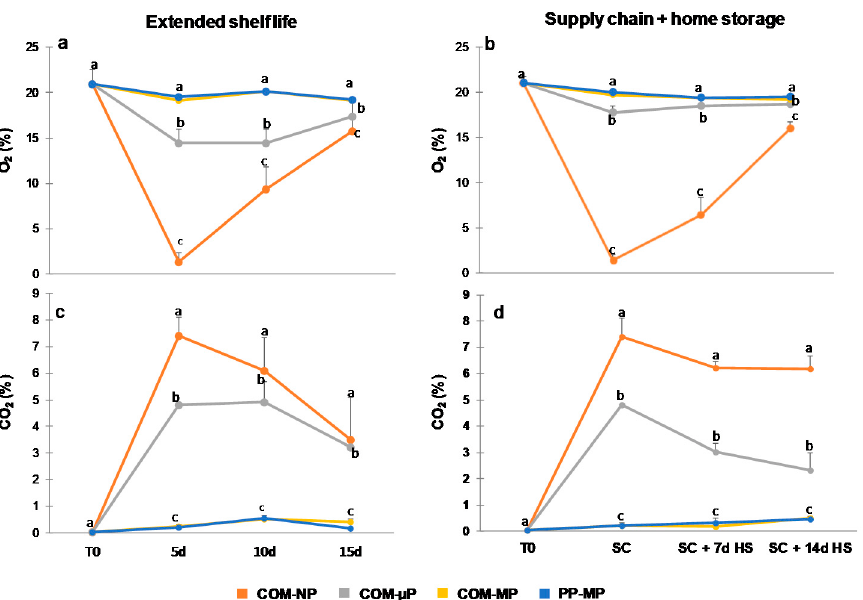
Figure 4. Oxygen and carbon dioxide levels in the headspaces of different cucumber packages. Measurements were taken during continuous storage under shelf conditions at 22 °C (Extended shelf life) and after the simulated farm-to-fork supply-chain treatment (2 days at 15 °C + 2 days at 22 °C) plus 1 or 2 weeks of refrigerated home storage at 4 °C (Supply chain + home storage). Figures ( a ) and ( b ) represent O 2 levels, and Figures ( c ) and ( d ) represent CO 2 levels after extended shelf life and farm-to-fork supply-chain conditions, respectively. Data are means ± SE of 3 replications. Different letters indicate significant differences at p ≤ 0.05. COM—compostable, PP—polypropylene, µ P—micro-perforated, MP—macro-perforated,